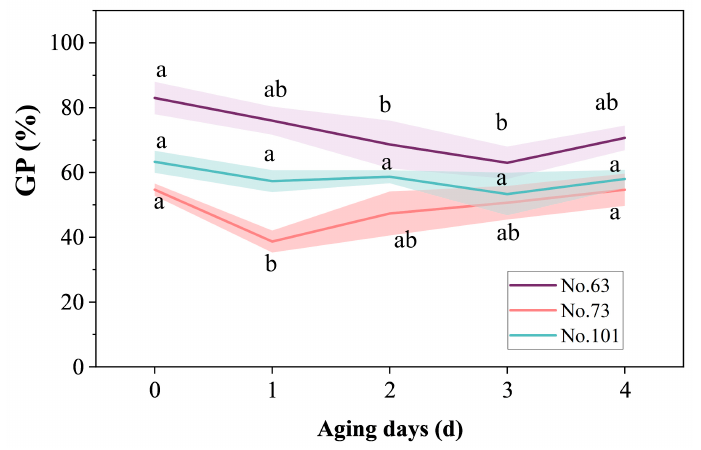
Figure 7. Effect of aging days on germination percentage of three varieties of pepper seeds. The different letters in the same cultivar are significantly different at 5% level.